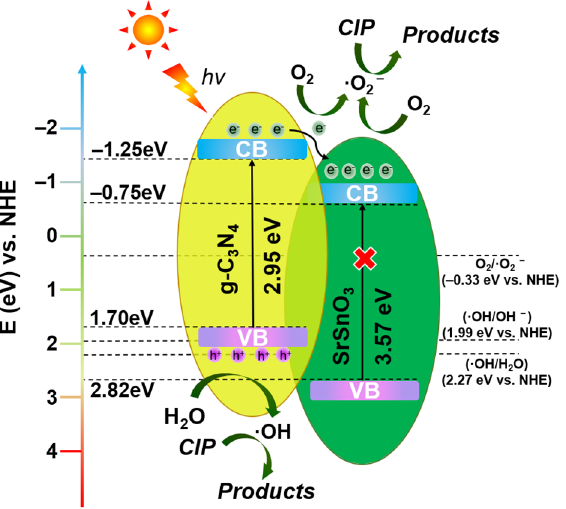
Figure 10. Possible mechanism of SSO/CN photocatalyst efficiency improvement.